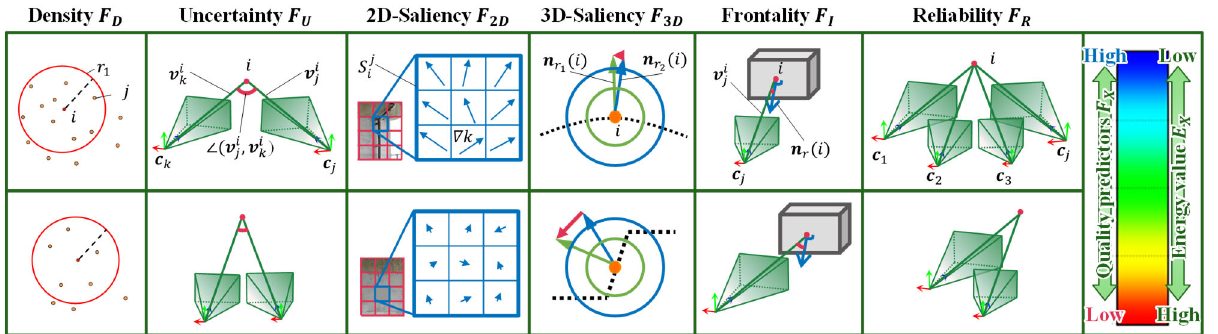
Figure 2. The process of the approximated triangular mesh model